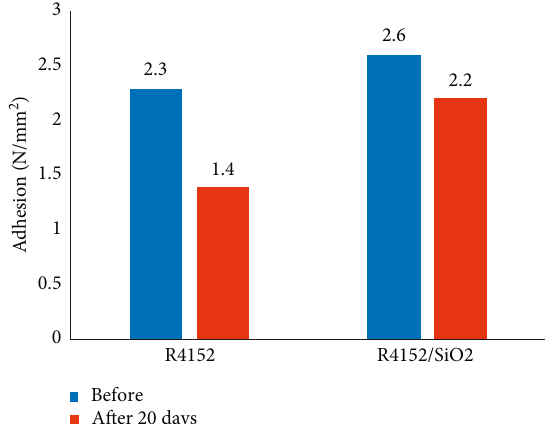
Figure 6: Adhesion of the acrylic coating without nano-SiO the acrylic coating with 2.5 wt% of nano-SiO 2 before and after immersion in the saturated Ca(OH) 2 environment for 20